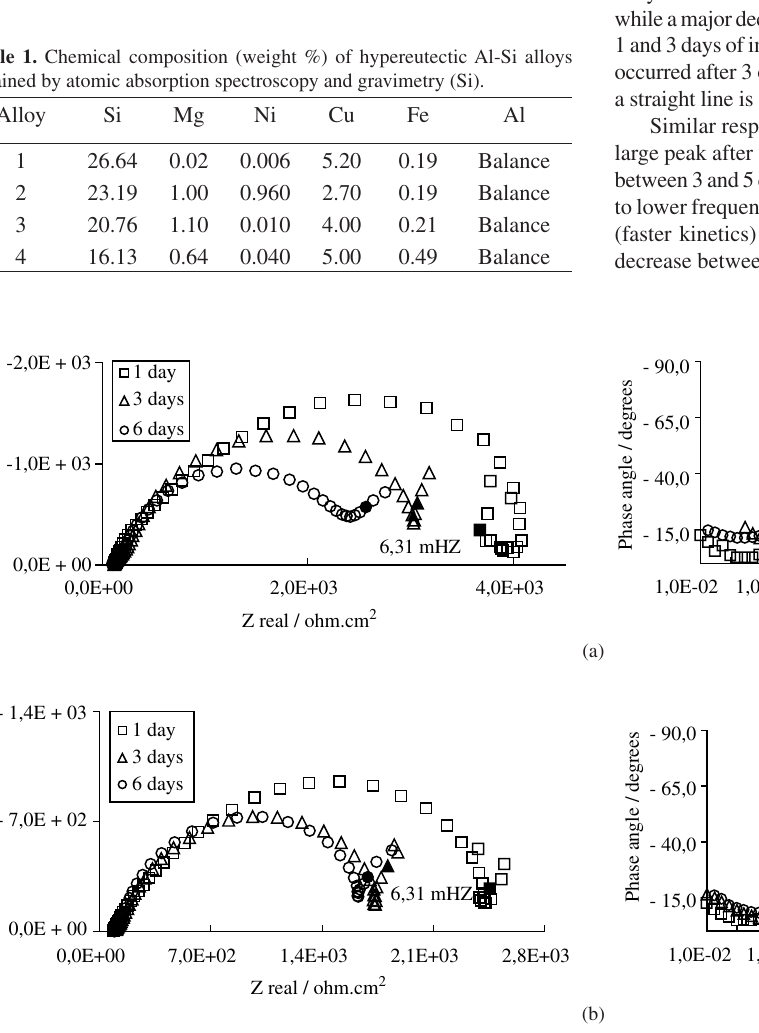
Figure 1. EIS results for hypereutectic Al-Si-Cu alloys at increasing immersion periods in naturally aerated CSAS, showing Nyquist and Bode phase diagrams for: a) alloy 1; b) alloy